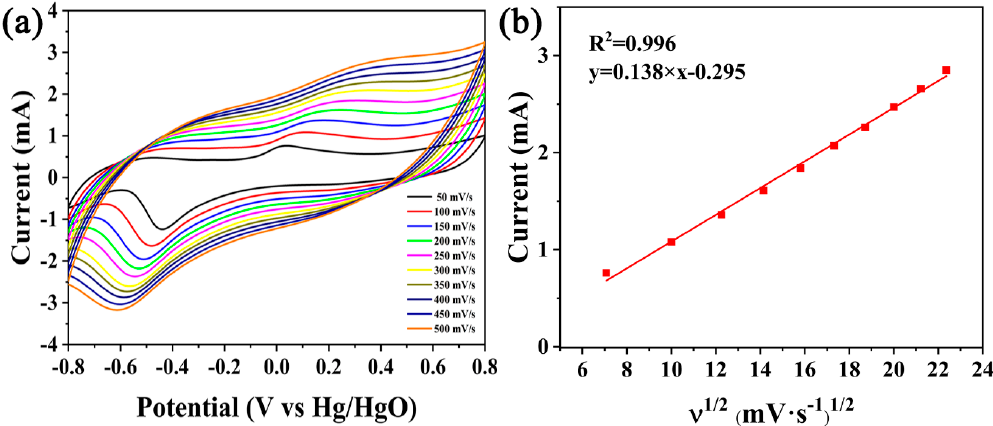
Figure 5. ( a ) CVs of the glucose electrooxidation reaction (GOR) at Pd/C 3 N 4 -C and ( b ) the corresponding plots of the anode peak currents vs. the square root of the scan rates in a 10 mM glucose + 0.1 M NaOH solution.